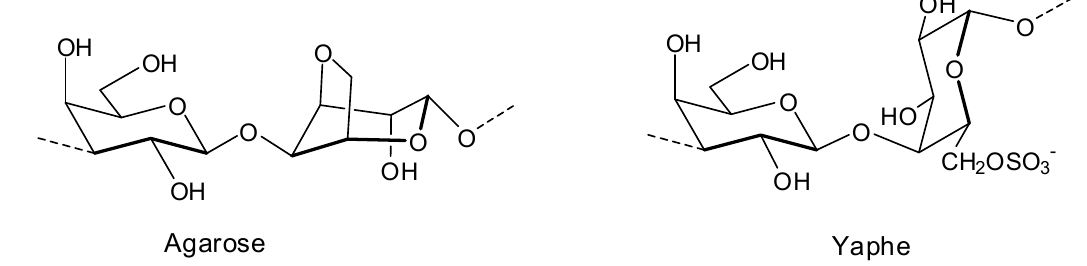
Figure 6. Agarose and Yaphe repeating units found in DL -galactan hybrids isolated from the red seaweed G. torulosus